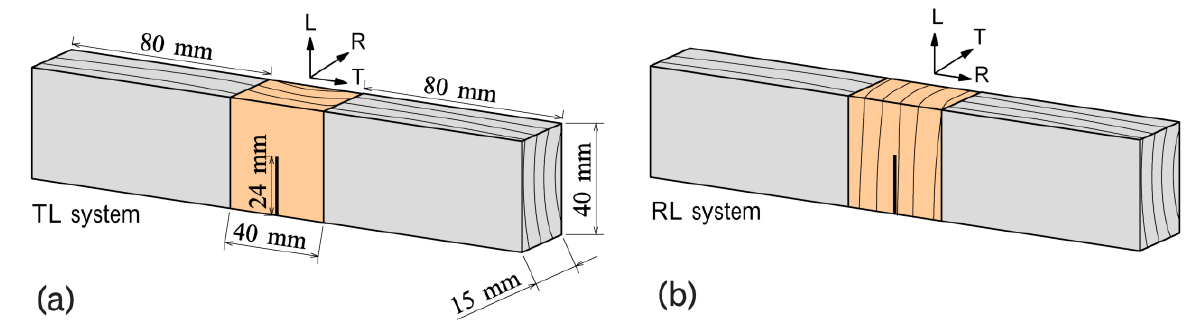
Figure 1. Specimens used in the single-edge notched bending test; ( a ) TL system (Tangential-Longitudinal); ( b ) RL system